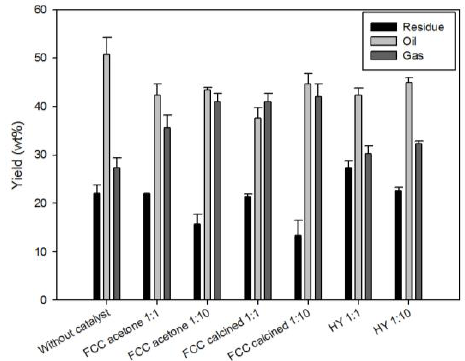
Figure 3. Yields of solid, liquid, and gas products of pyrolysis obtained under different catalytic conditions.